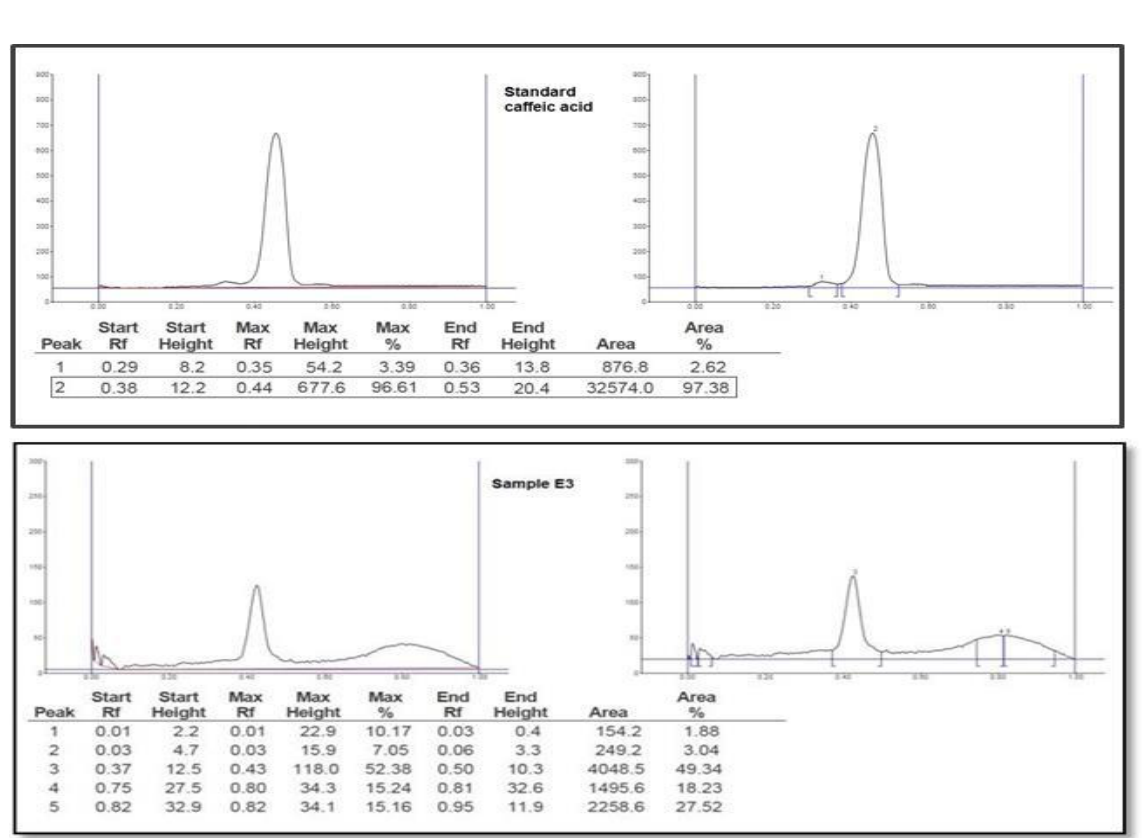
Figure 5. HPTLC chromatogram of standard and sample E3 caffeic acid at